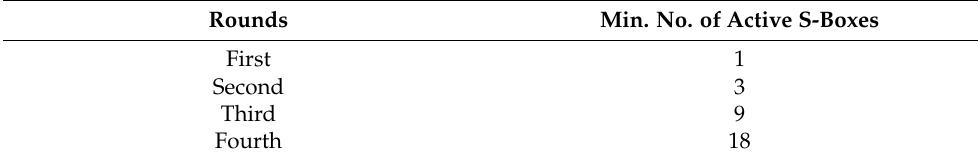
Table 4. Minimal Number of Active S-boxes from the Linear Characteristics.